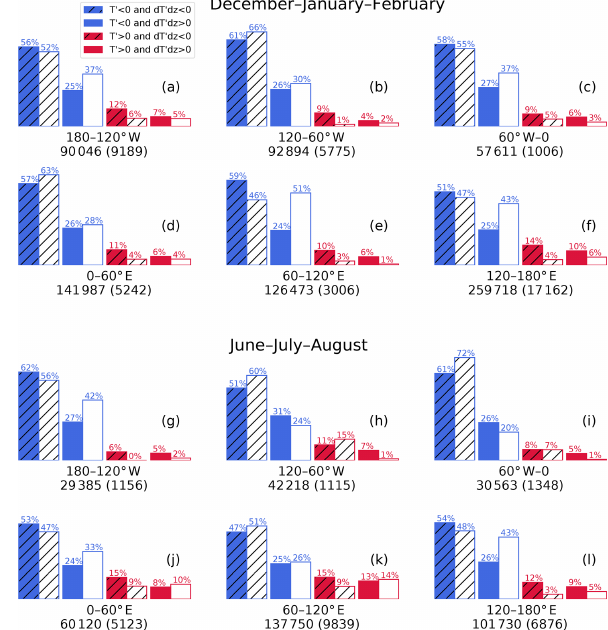
Figure 4. Same as Fig. 3a except for different longitudinal belts. (a) – (f) are for December–January–February and (g) – (l) are for June–July–August. Filled bars represent all TTL clouds, while un- filled bars represent only clouds above the mean tropopause of the respective longitudinal belt and season. The numbers of all cloud bins and bins above the tropopause (in parentheses) in each longi- tudinal belt are labeled under each bar